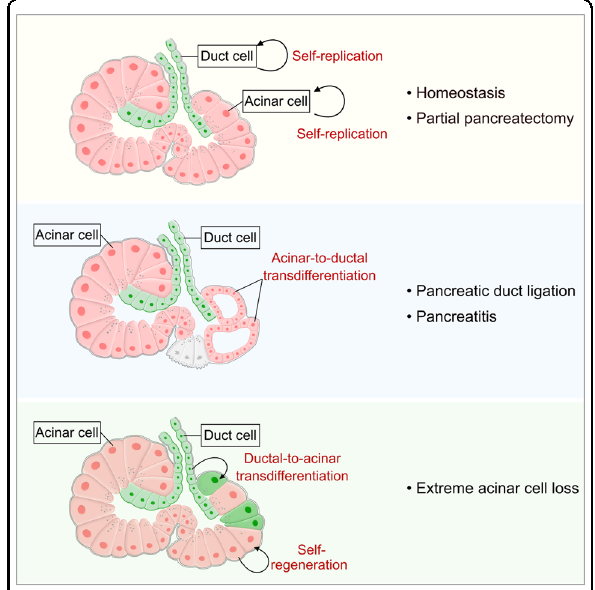
Fig. 8 The cell fate transdifferentiation between pancreatic acinar cells and duct cells in adults. Cartoon showing a dual recombinase-mediated genetic lineage tracing of pancreatic acinar cells and duct cells